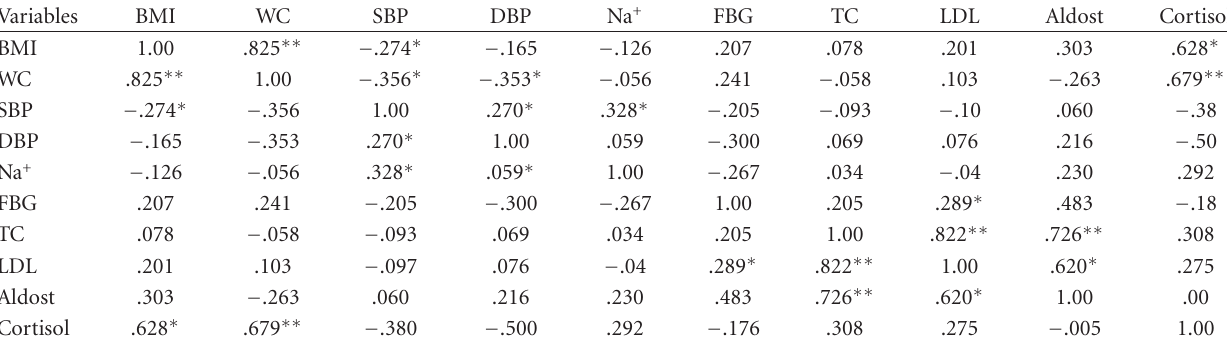
Table 3: Pearson’s correlation ( r ) among important variables, showing relationship of di ff erent variables with one another in prehypertension group.